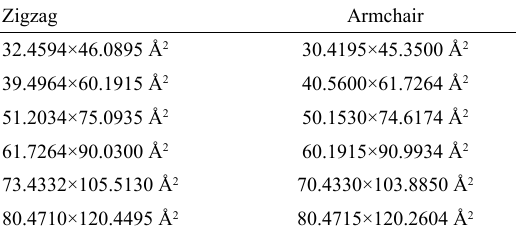
Table 1: Dimensions of armchair and zigzag nanosheets with the aspect ratio of 1.5 Zigzag